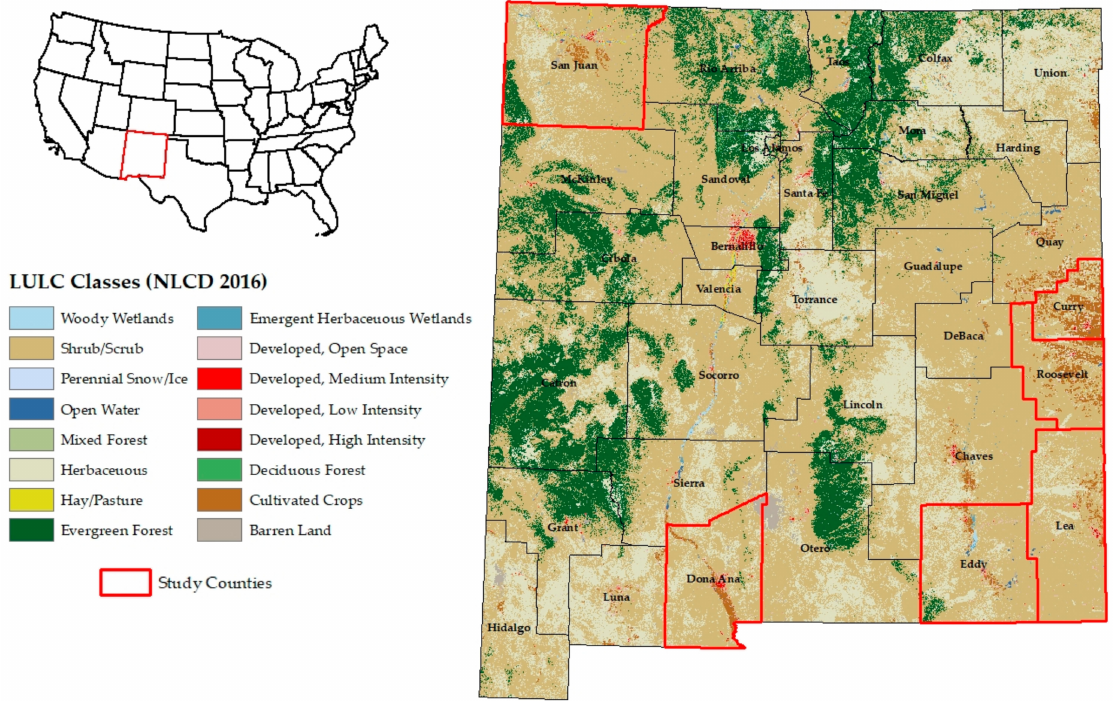
Figure 1. Description of the study location showing the contiguous US, New Mexico, and the six counties (i.e., San Juan, Doña Ana, Curry, Roosevelt, Lea, and Eddy) overlaid with the single-date National Land Cover Database (NLCD) of 2016 map of New Mexico. LULC = land use / land